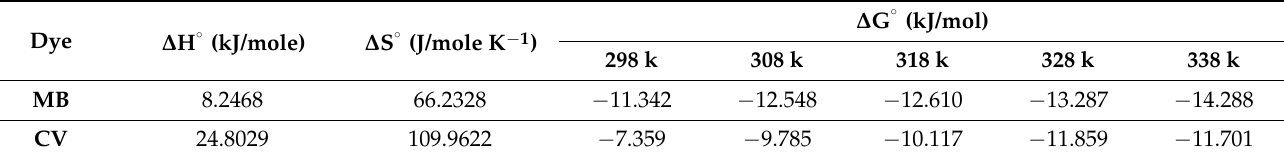
Table 4. Thermodynamic parameters for the sorption of MB and CV onto T-BC.